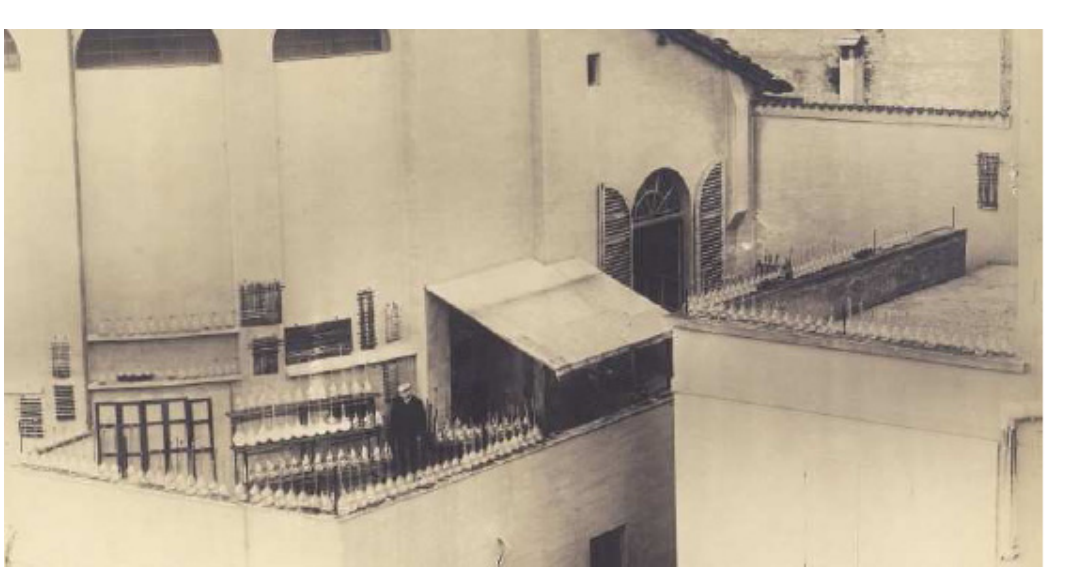
Figure 3. The dawn of photochemistry. Ciamician surrounded by a number of sun-exposed flasks on his laboratory terrace at the University of